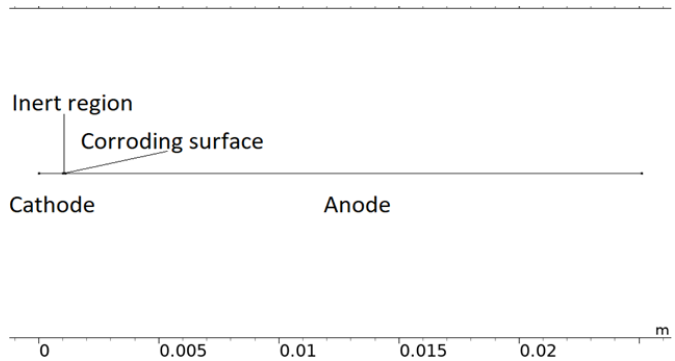
Figure 3. The 1D model geometry of the calibration cell.